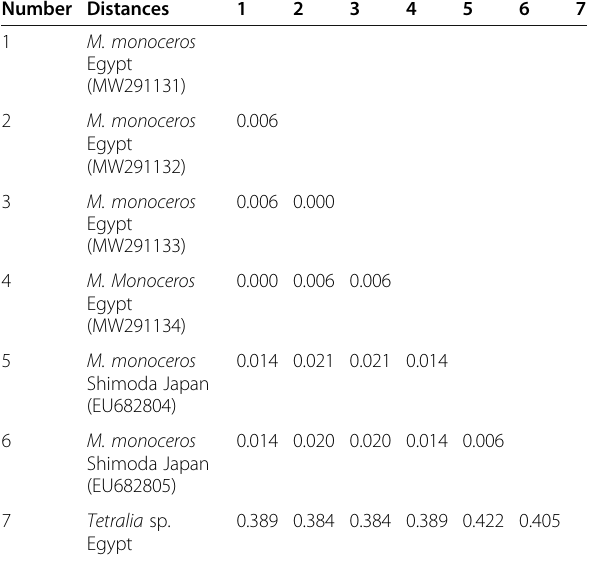
Table 4 Pairwise genetic distances between the studied specimens ’ sequences compared with the sequences obtained from GenBank 16S sequences of M .